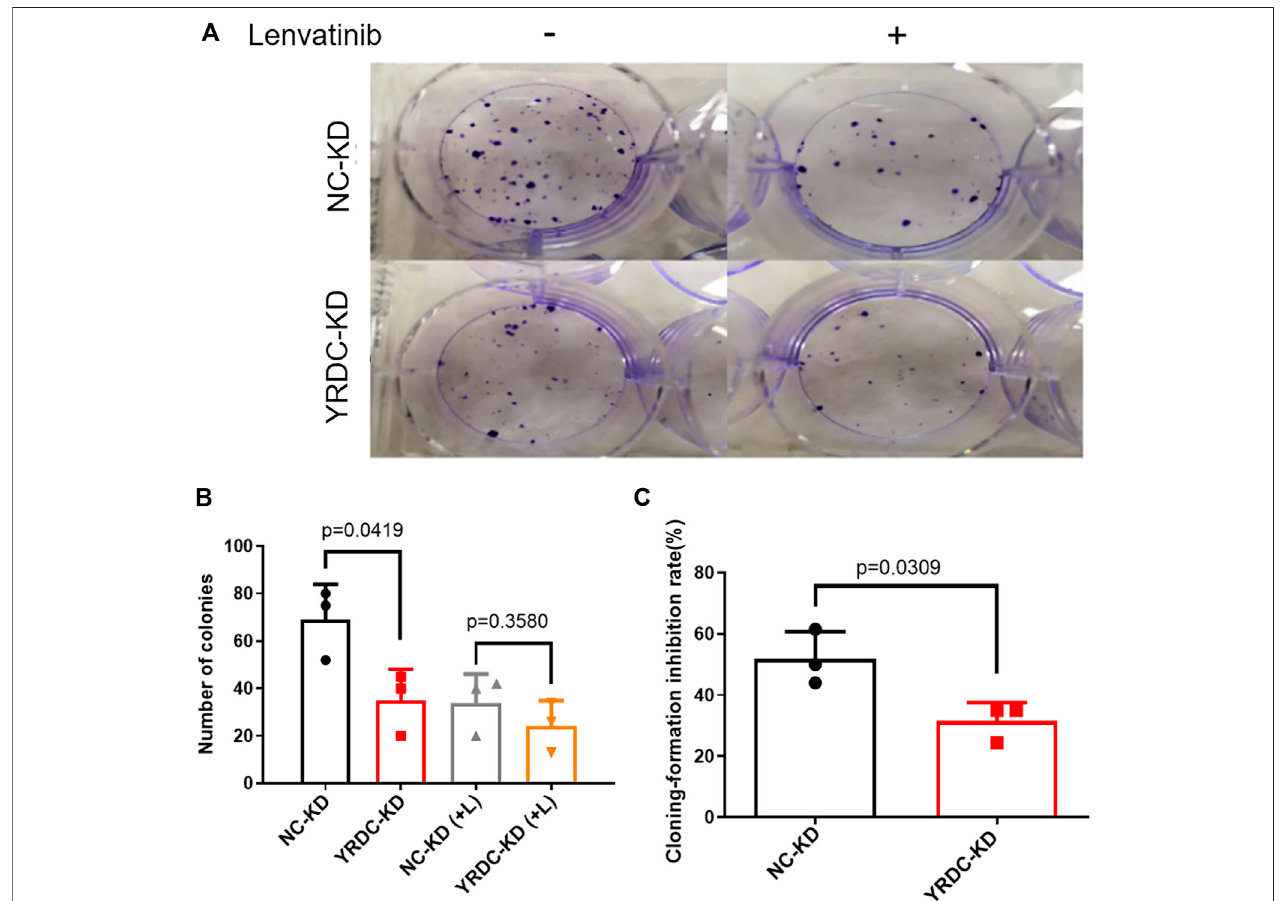
FIGURE 3 | The knockdown of YRDC attenuates cellular sensitivity to lenvatinib in the clone formation assay. (A) The knockdown of YRDC attenuates the anti – colony-formation effect of lenvatinib (0.1 μ M). (B) The clonal cell number was measured after 15 days in Huh7 cells with lenvatinib. (C) The cloning-formation inhibition rate refers to the inhibition rate after lenvatinib addition. Dots in the graphs mean biological repetitions, n (cid:2) 3.